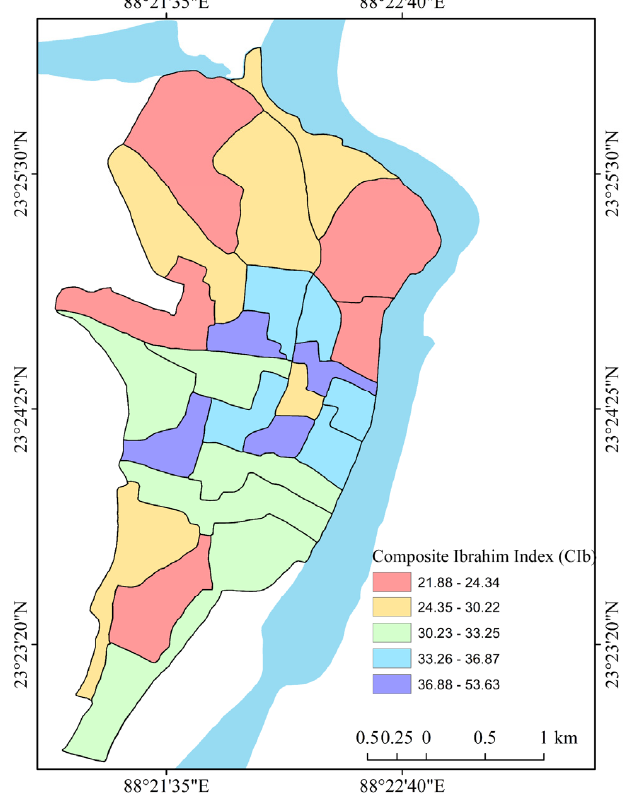
Figure 60. Ward ‐ wise composite Ibrahim index of development in Nabadwip Municipality (2015). Figure 60. Ward-wise composite Ibrahim index of development in Nabadwip Municipality